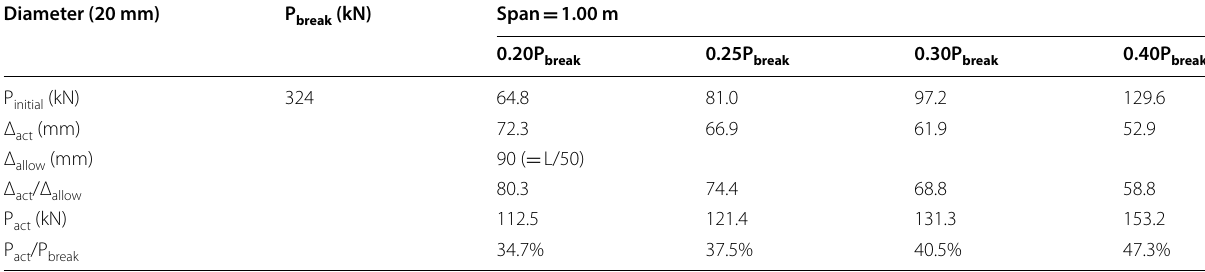
Table 4 W 1.0 m structural analysis result. =